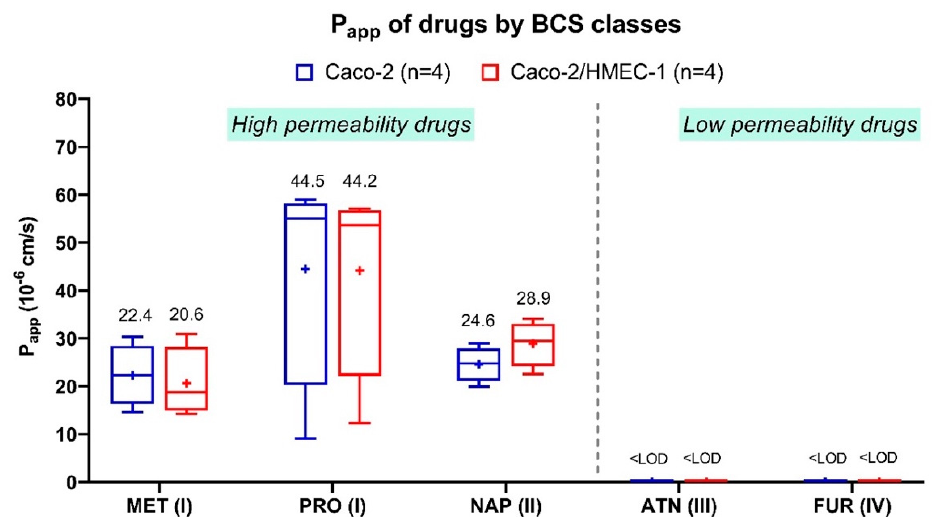
Figure 3. Average apparent permeability (P app ) of five drugs ( n = 4) classified by four BCS classes across Caco-2 cells (blue) and HMEC-1/Caco-2 coculture cells (red). MET = metoprolol, PRO = propranolol, NAP = naproxen, ATN = atenolol, FUR = furosemide; BCS class numbers are signified in the parentheses. LOD means the limit of detection = 10 ng/mL. The (+) symbol represents the arithmetic mean, and the whiskers represent a 95% confidence interval (Kruskal–Wallis).